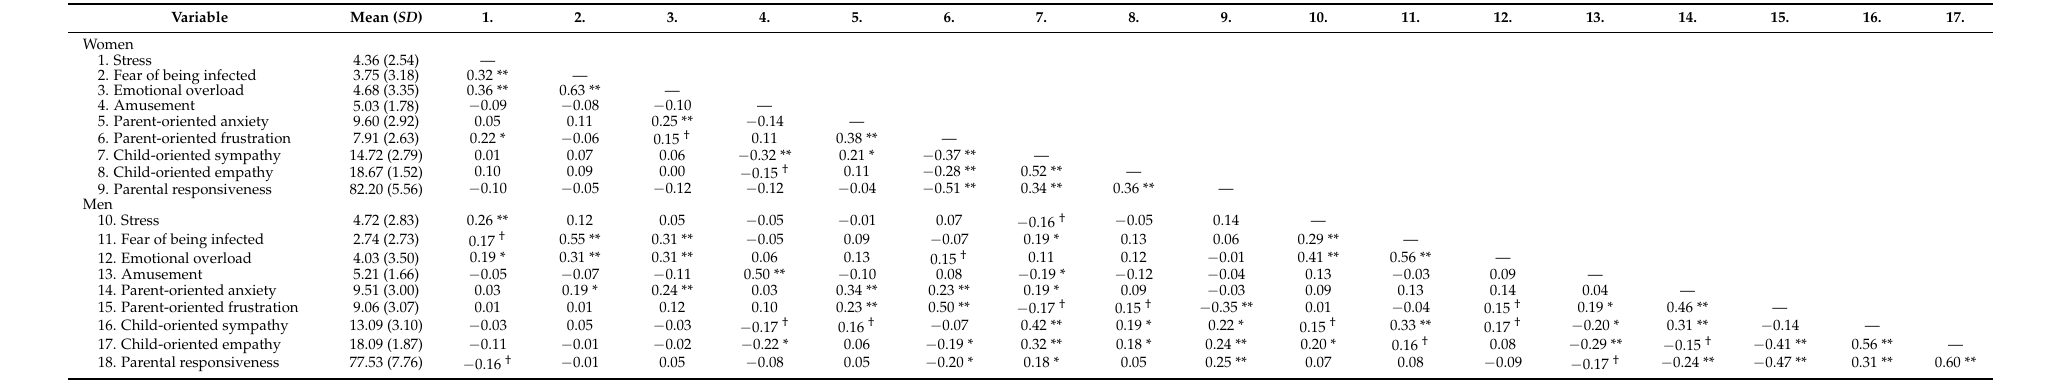
Table 1. Mean scores and standard deviations ( SD ), percentages, and Pearson correlation coefficients between